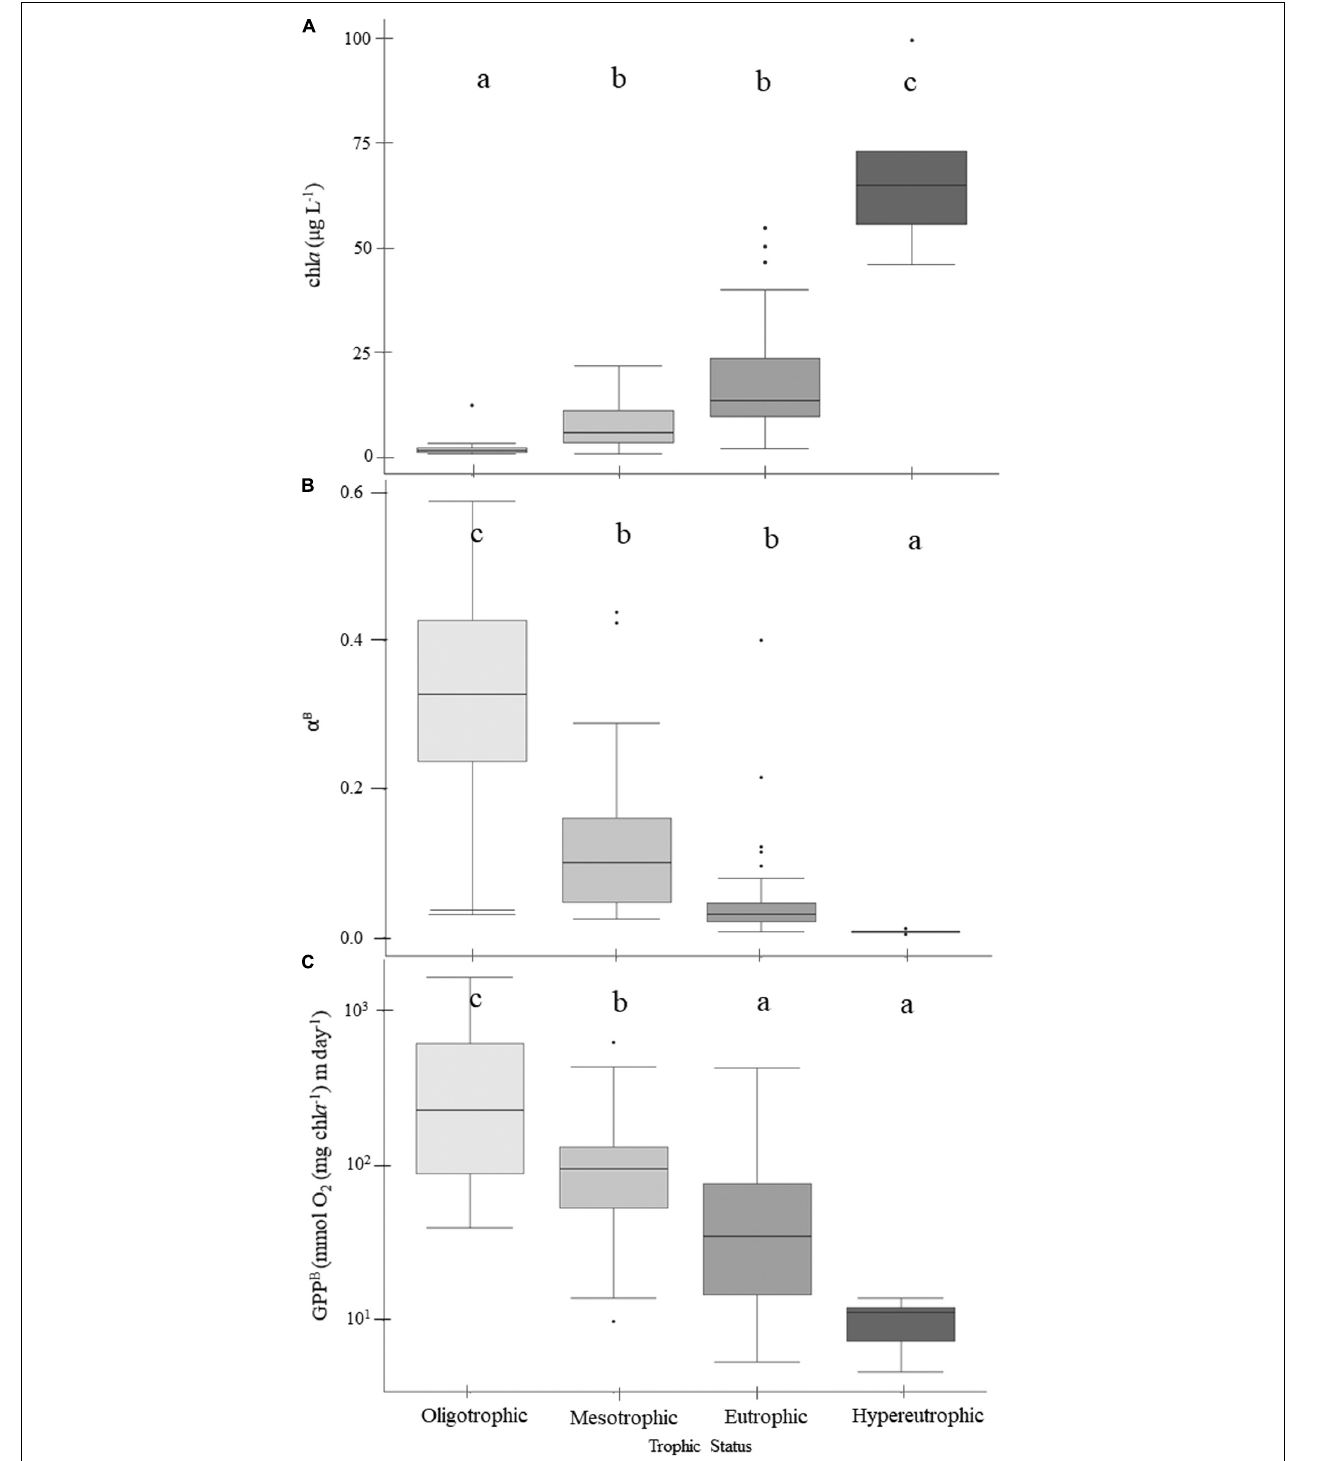
FIGURE 3 | Patterns of chlorophyll- a (A) , light utilization efficiency per unit of chlorophyll- a (B) , and gross primary production (GPP B ) rates normalized to chlorophyll- a (C) across the trophic gradient. Within the boxplots, the 50th percentile (median) is visualized with a solid horizontal line. The 25th and 75th percentiles are represented by box hinges above and below the median line. On either end of the box, whiskers denote the smallest and largest values within 1.5 × the interquartile range (IQR) and points indicate values beyond 1.5 × the IQR. Lowercase letters indicate results from multiple comparison post-hoc tests, where similar letters denote no significant differences between trophic states ( Table 5